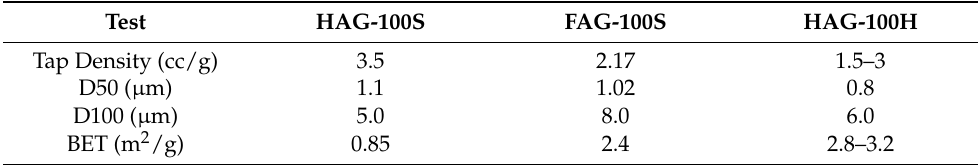
Table 2. Basic information of silver